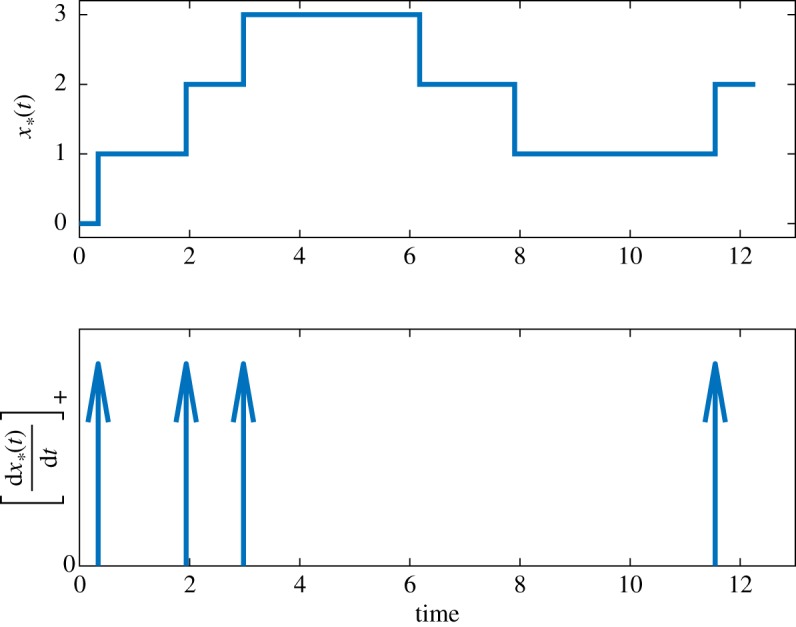
An example x∗(t) and [dx∗(t)/dt]+.